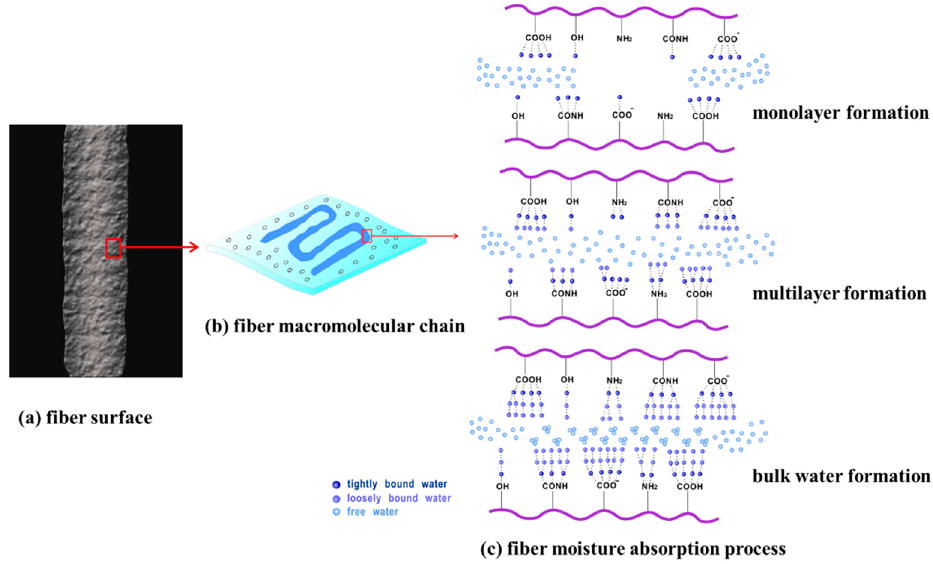
Figure 4. Experimental data and Guggenheim-Anderson-de Boer (GAB)-predicted GAB-predicted water vapor adsorption isotherms at different temperature for different fiber samples (symbols are experimental data and solid lines are the model predictions).